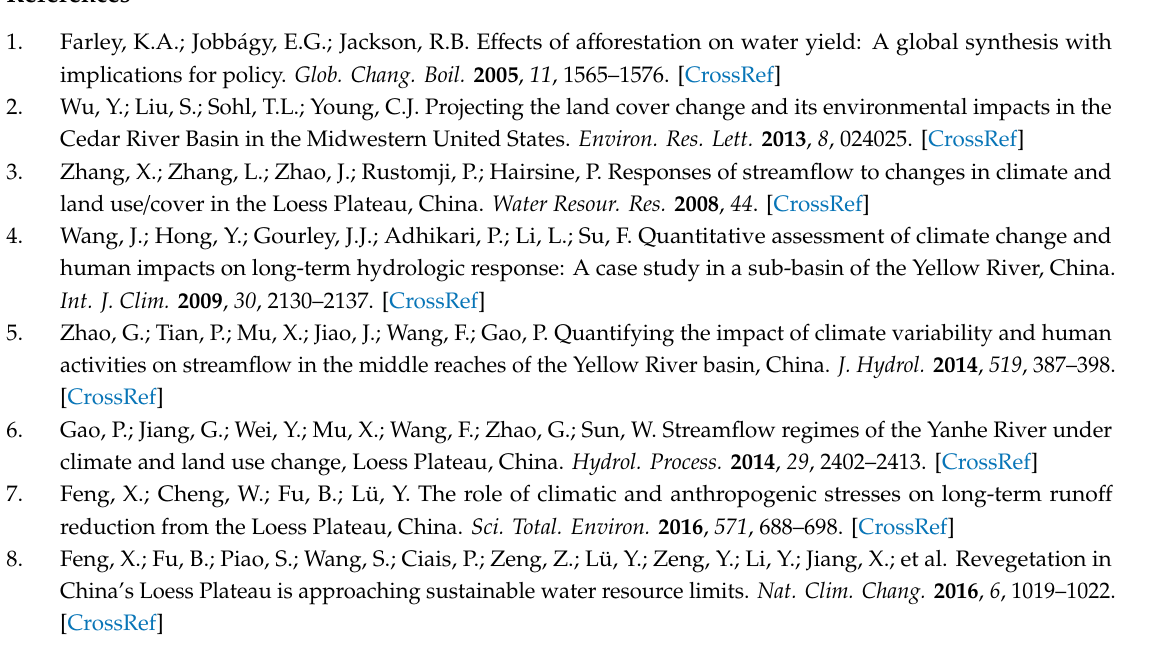
s1. Figure S1. Spatial distribution of multi-year average (a) precipitation, (b) temperature, (c) potential evapotranspiration, (d) dryness, during 1961–2016. Figure S2. Percentage of the runo ff over the three sub-regions to total runo ff over the Weihe basin. Figure S3. Population (POP) and Gross Domestic Product (GDP) of the Weihe River basin and the three sub-regions since 1990. Table S1. Variability of four meteorological variables over the Weihe River basin for di ff erent